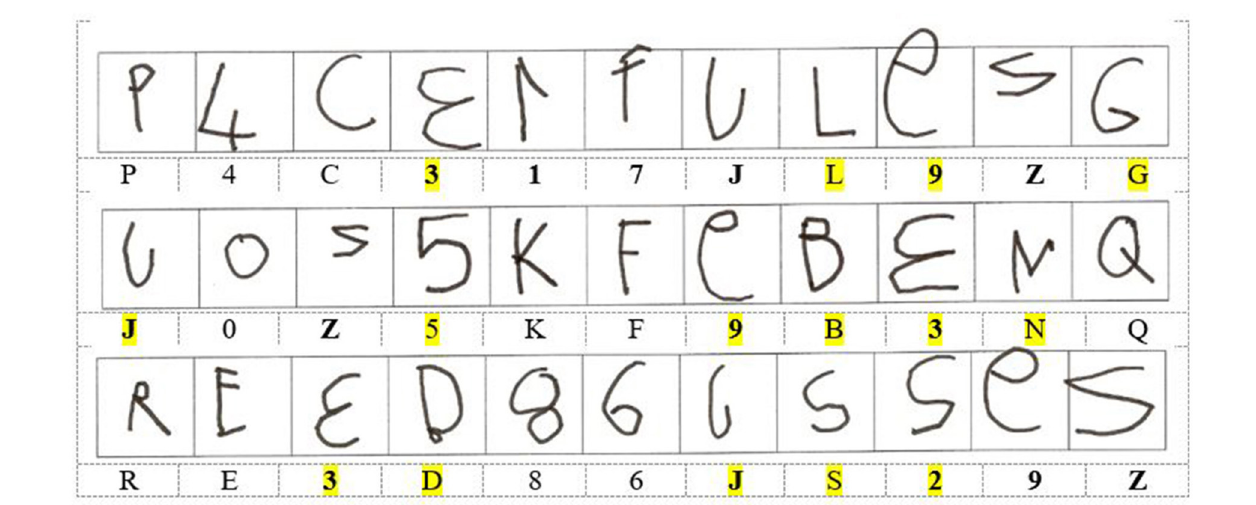
FIGURE 1 | Writings of three series of independently dictated characters by a girl aged 6 years 2 months, who spontaneously wrote with her right hand (from raw data from Fischer and Tazouti, 2012, Expt 2). Mirror-reversed characters are shown in bold below the child’s writings. Writings requiring a jump from a representation in one hemisphere to a representation in the other hemisphere, following Orton’s (1925) hypothesis, are highlighted in